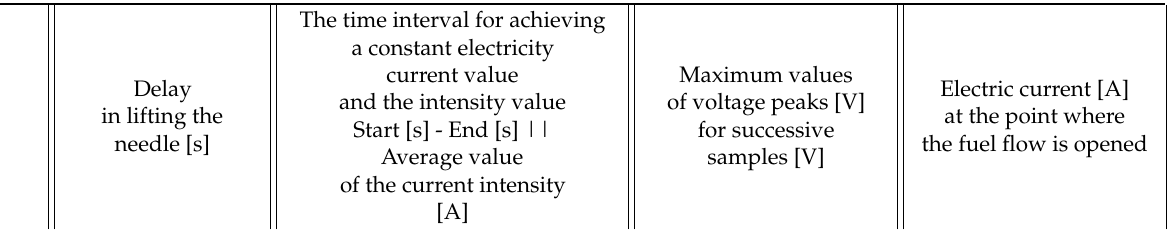
Table 1. User panel filled with selected